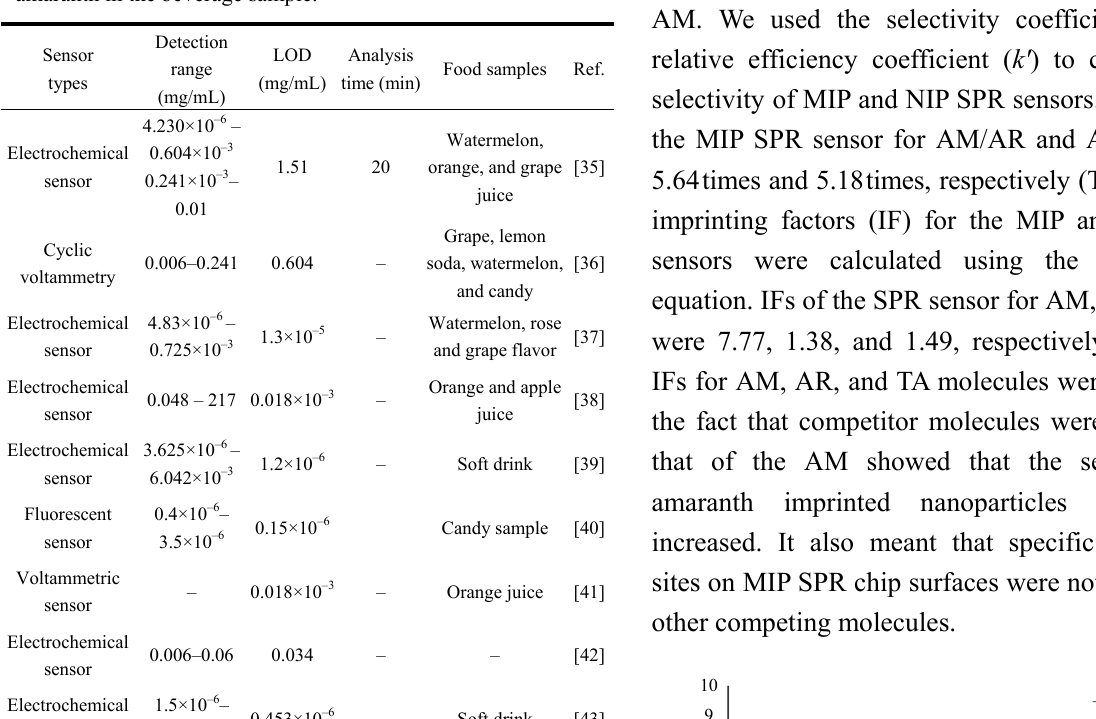
Table 1 Examples of different sensor studies for detection of amaranth in the beverage sample.